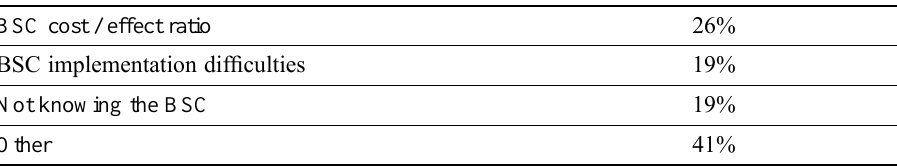
Table 11. Justification for not using the BSC